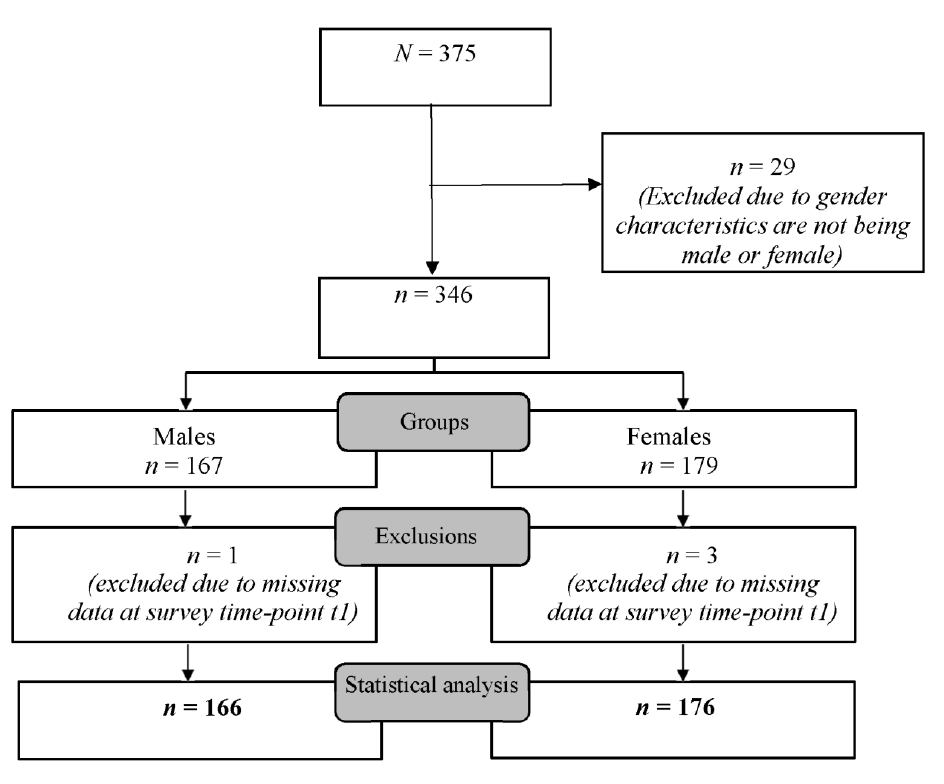
Figure 1. Data extraction sheet.